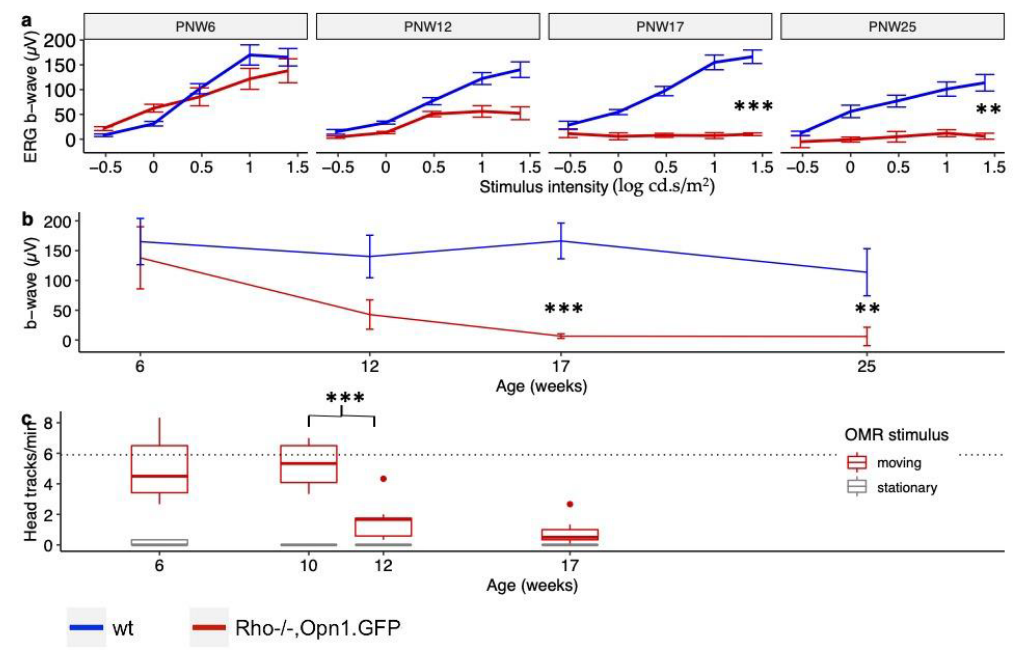
Figure 4. Changes in retinal function in Rho − / − OPN1-GFP mice. ( a ) Light-adapted ERG b-wave amplitudes for a range of stimulus intensities ( − 0.5 to 1.5 log cd.s / m 2 ) comparing Rho − / − OPN1-GFP mice and wild-type mice at PNW 6 ( n = 7; n = 6, respectively), PNW 12 ( n = 2; n = 5), PNW 17 ( n = 7; n = 6) and PNW 25 ( n = 3; n = 4). *** denotes p < 0.001; ** denotes p < 0.01; All values mean ± SEM. ( b ) The same ERG data, displaying only the light-adapted ERG b-wave amplitudes for 1.5 log cd.s / m 2 flash stimulus for both mouse strains over time. There is rapid loss of cone function in Rho − / − OPN1-GFP mice. All values mean ± SEM. ( c ) OMR photopic head-tracking behavior in Rho − / − OPN1-GFP mice at PNW 6 ( n = 5 mice), PNW 12 ( n = 3), PNW 17 ( n = 4), and PNW 25 ( n = 5). Loss of head tracking occurs between 10 and 12 weeks ( p < 0.001). Null-stimulus OMR test conditions provided as controls (grey boxes) and ‘wt’ OPN1-GFP mouse head-tracking behavior provided as healthy reference (dotted line). All values IQR ± 95% CI, points represent outliers.